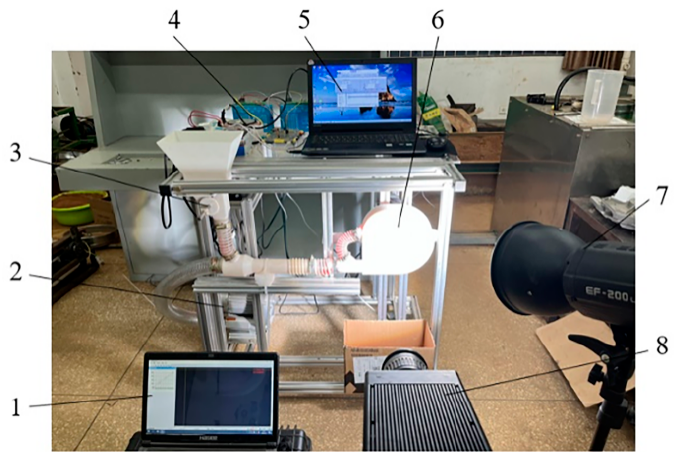
Figure 9. Air-assisted high-speed precision seed metering system test bench. 1. Computer I; 2. fan; 3. seed feeding wheel; 4. control module; 5. computer II; 6. seed rower; 7. fill light; 8. high-speed camera.